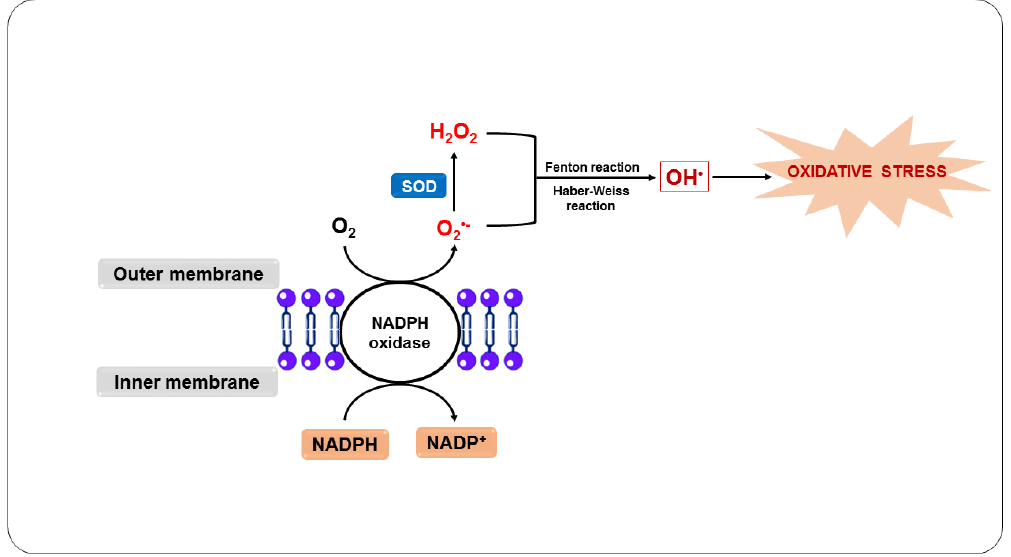
Figure 2. Oxidative stress as a host defense mechanism in response to infection by Plasmodium